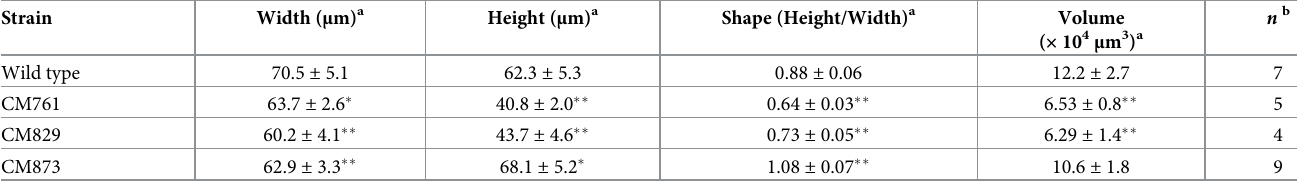
Table 1. Width, height, shape, and volume of shoot apical meristem of wild type and mutants at early P1 stage.